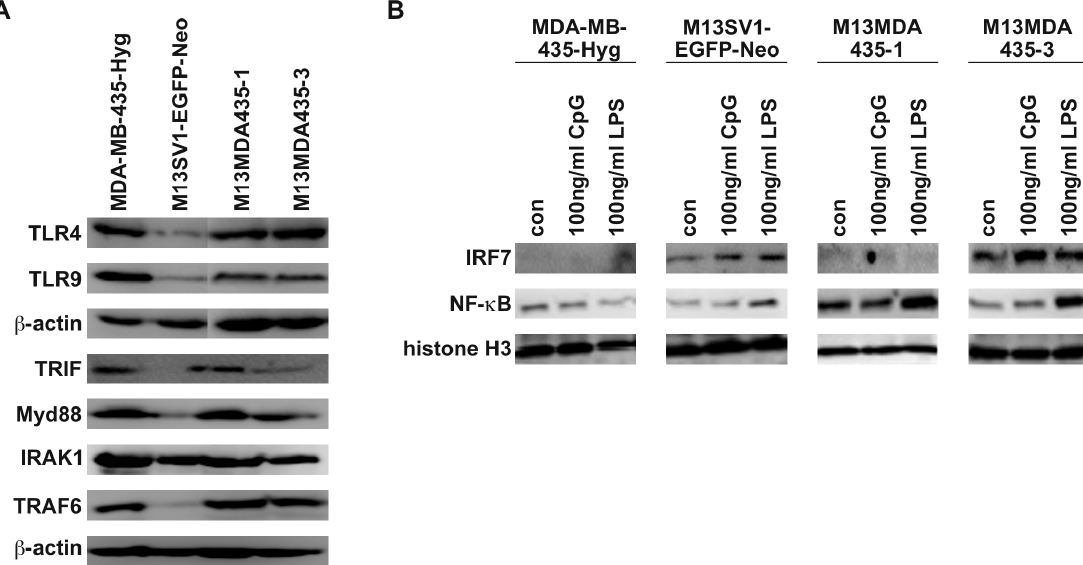
Figure 1. Expression of TLR4 and TLR9 and components of the TLR signal transduction cascade. ( A ) M13SV1-EGFP-Neo breast epithelial cells express lower levels of TLR4 , TLR9 , TRIF , Myd88 and TRAF6 in comparison to the other cells; ( B ) Nuclear translocation of IRF7 was found in LPS and CpG-ODN (CpG) treated M13SV1-EGFP-neo cells and M13MDA435-3 hybrid cells, but not MDA-MB-435-Hyg breast cancer cells and M13MDA435-1 hybrid cells. By contrast,